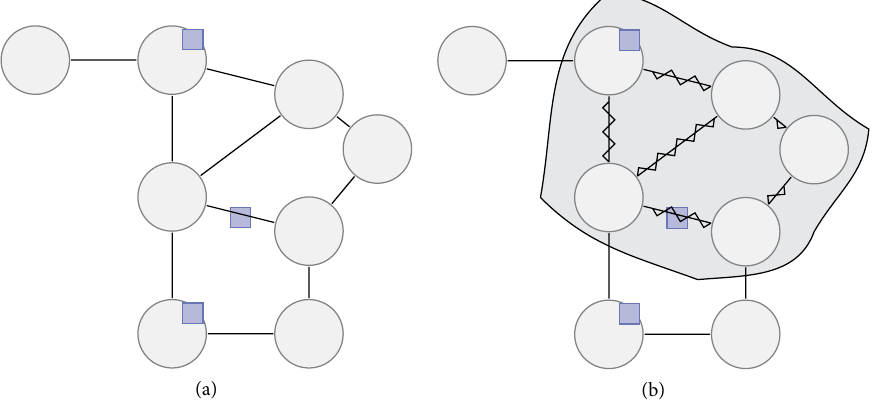
Figure 1: (a) Without 𝑘 -club, (b) with 𝑘